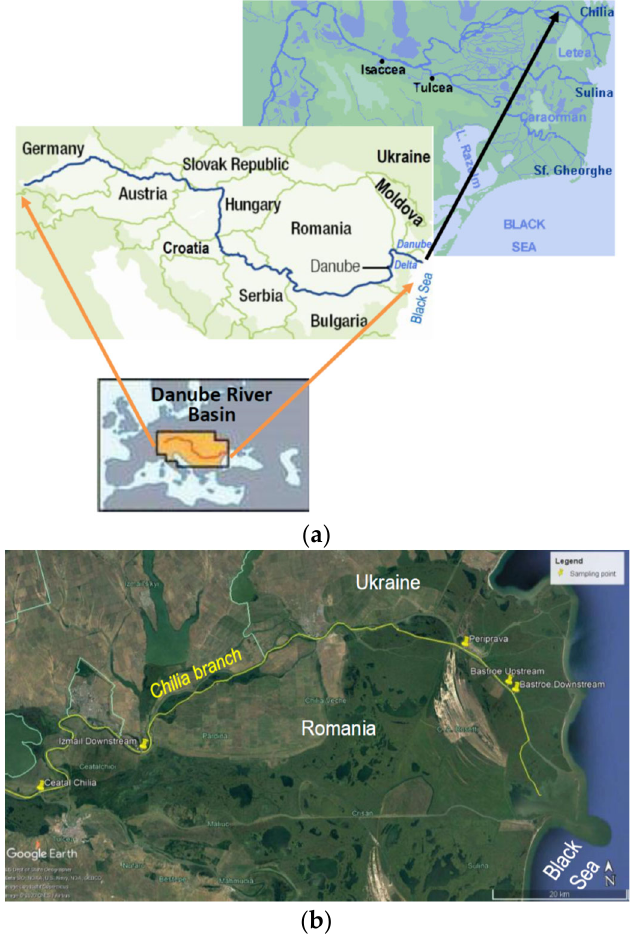
Figure 1. Geographical location of: ( a ) Danube River basin, Danube Delta, and the three branches (Chilia, Sulina, and Sfantu Gheorghe), and ( b ) sampling points from Danube River Chilia branch.